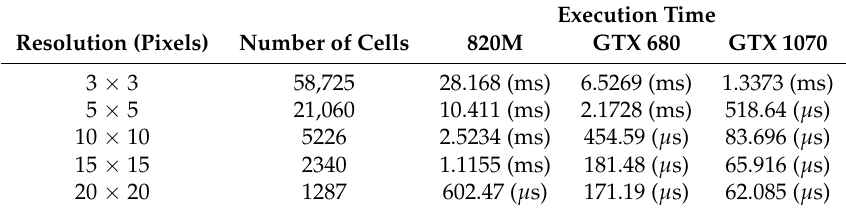
Table 6. Execution times for flood simulations which are performed on Linux Ubuntu PCs